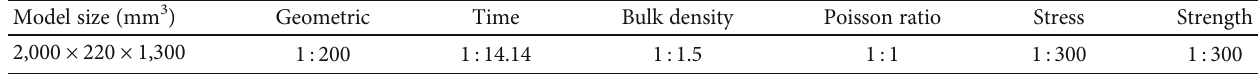
Table 1: Similarity condition of similar material simulation model to actual mine system.